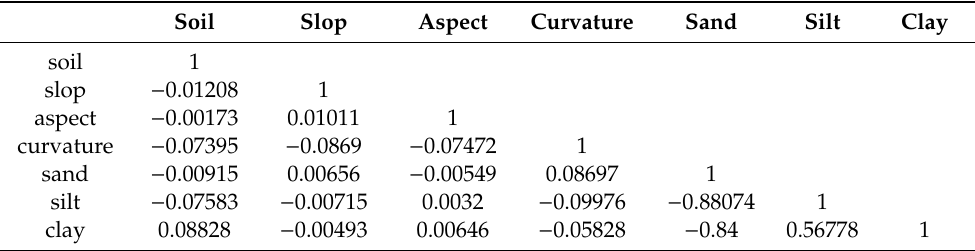
Table A3. Correlation matrix of topographic and soil